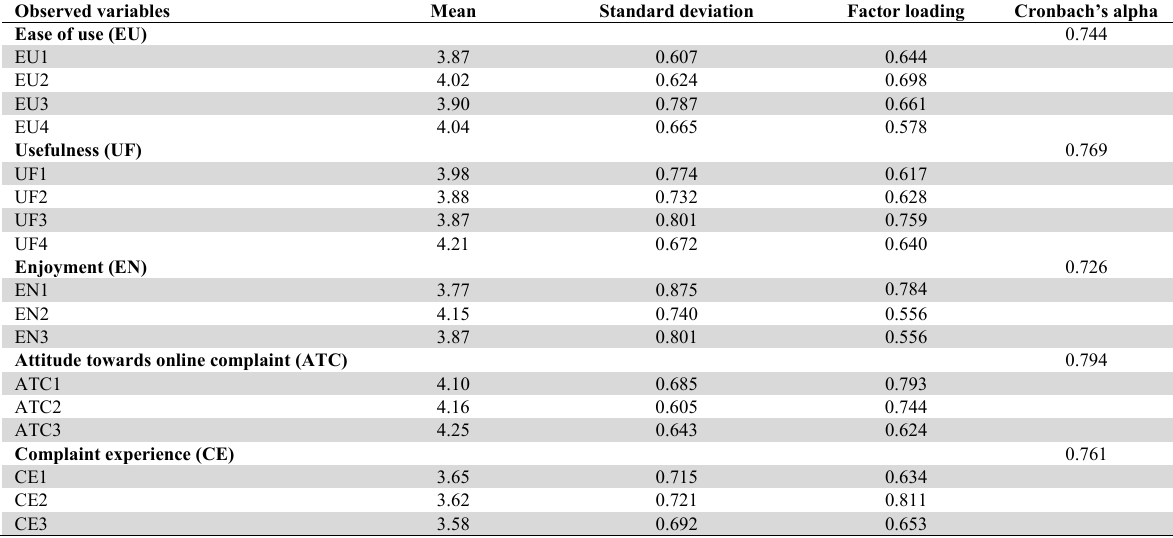
Reliability test